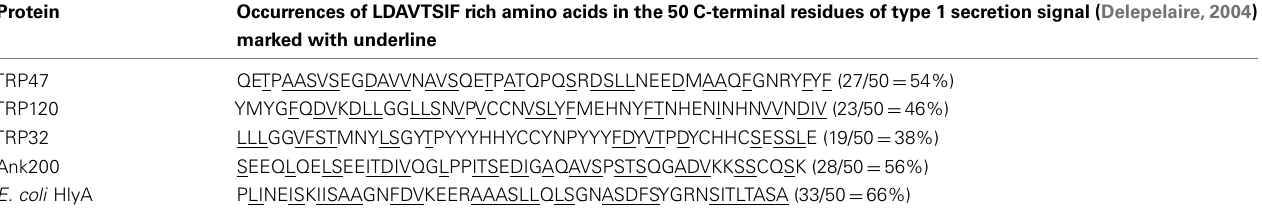
Table 2 |Analysis of 50 C-terminal residues for occurrence of type 1 secretion signal.